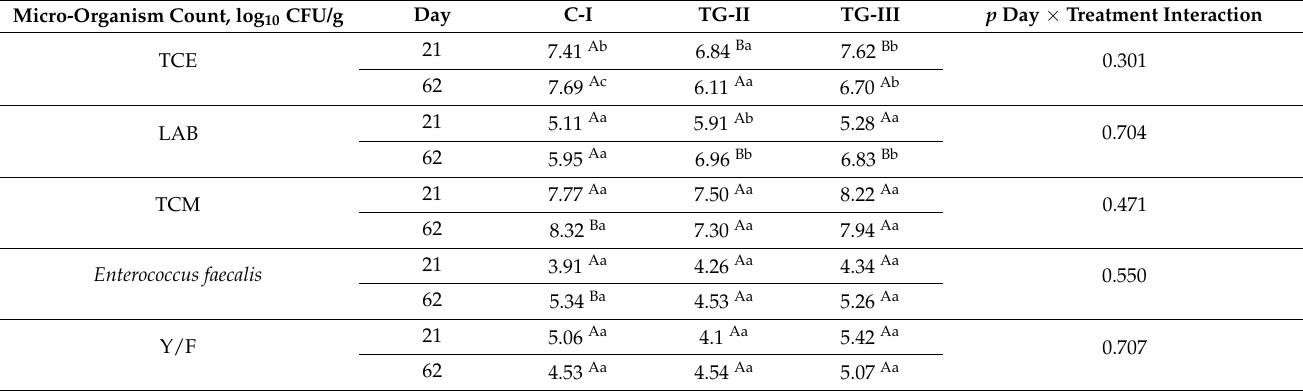
Table 5. Microbiological parameters in the samples of pig